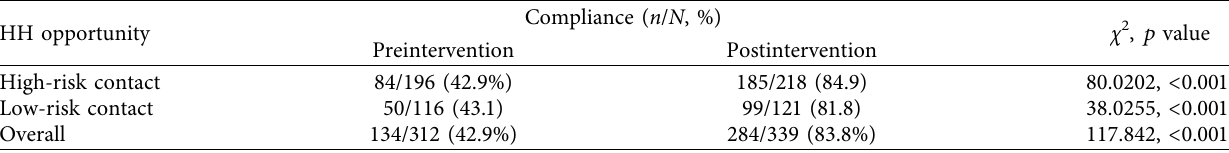
Table 4: Comparison of changes in hand hygiene compliance before and after intervention based on the risk category.